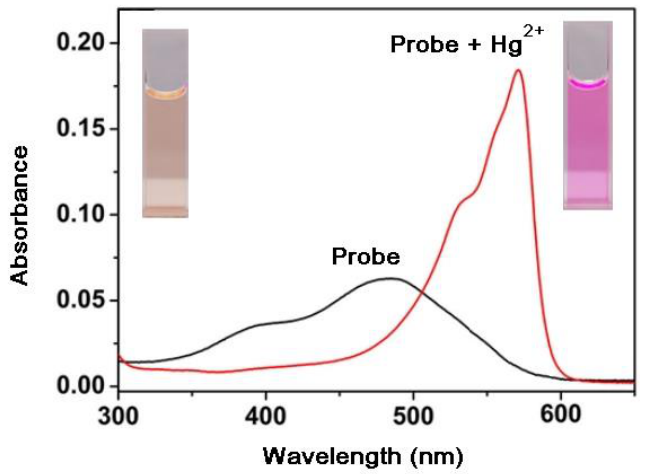
Figure 1. The absorption spectra of VRF (10 μ M) in the absence and presence of Hg 2+ (100 μ M) in CH 3 CN/HEPES buffer solution (1:1, v / v , 0.1 M, pH 7.4). Inset: the change in the colour of VRF in the absence and presence of Hg 2+ (colourless to pink).